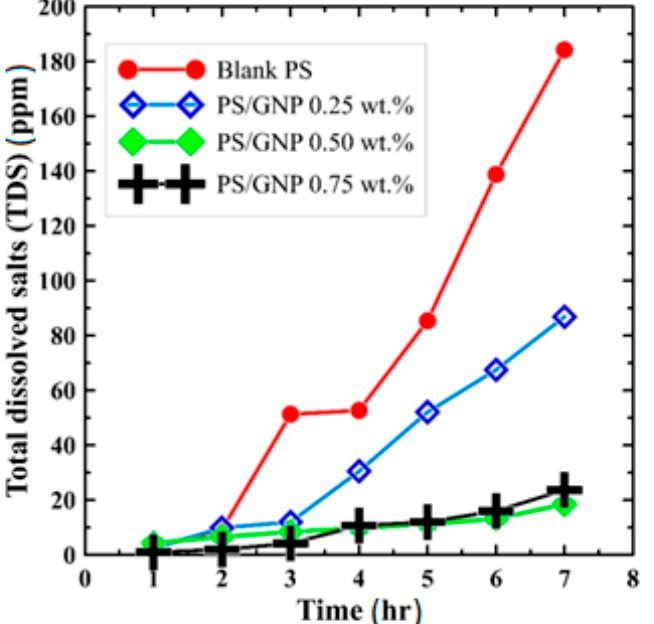
Figure 7. Comparison of permeate flux quality (TDS) for all fabricated membranes over 7 h operat- ing time.